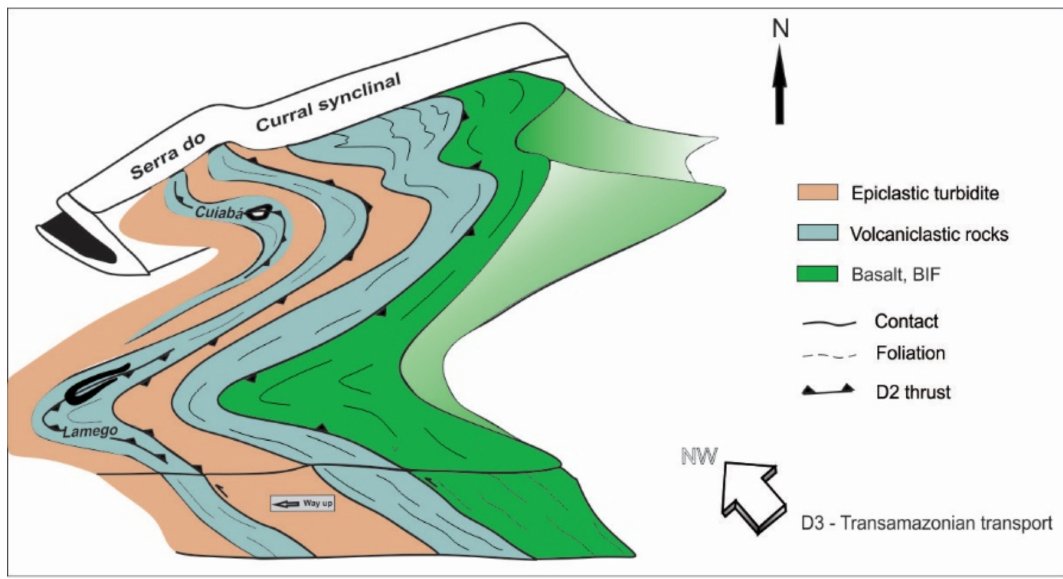
Figure 13. Schematic diagram showing two generations of Archean and Paleoproterozoic superimposed folds. Cuiab á and Lamego intrafolial folds are D1–D2 Archean folds, in the flanks of D3 Transamazonian megafolds.